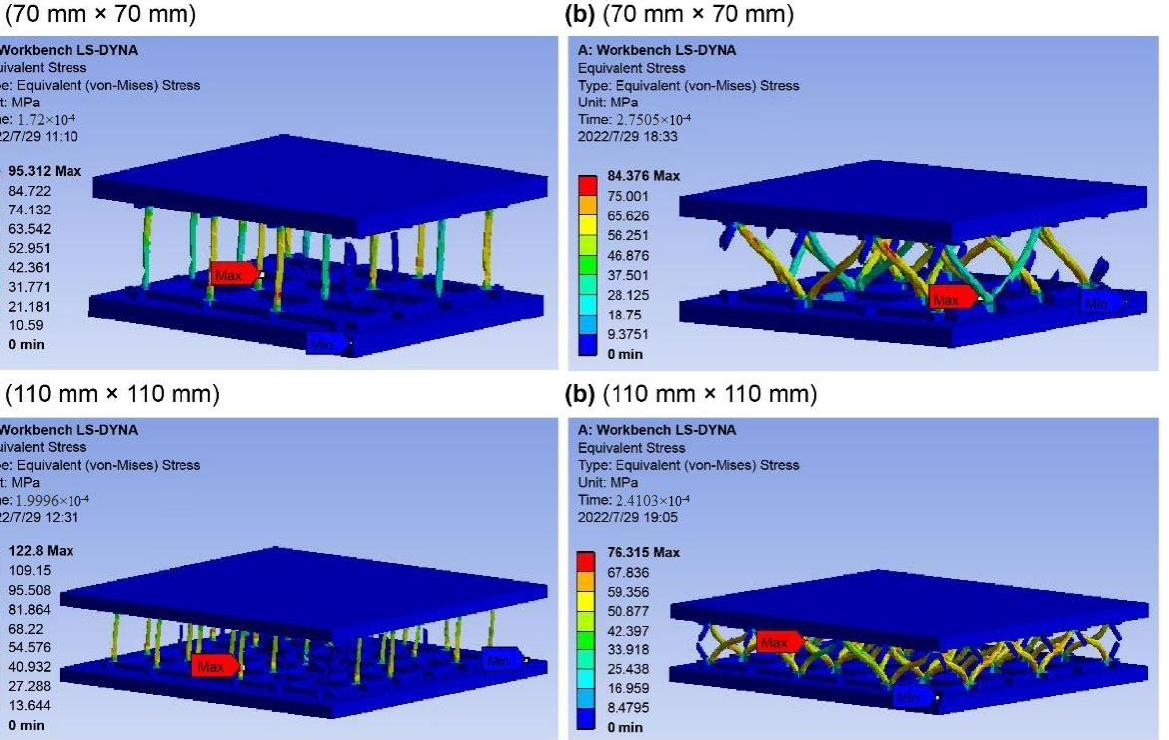
Figure 14. Flat compression failure stress distributions at the maximum external force. the double- sided, square shallow groove, and cylindrical deep holes ( a ) and optimized Warren truss with symmetrically inclined holes ( b ) resin stiffener structures.